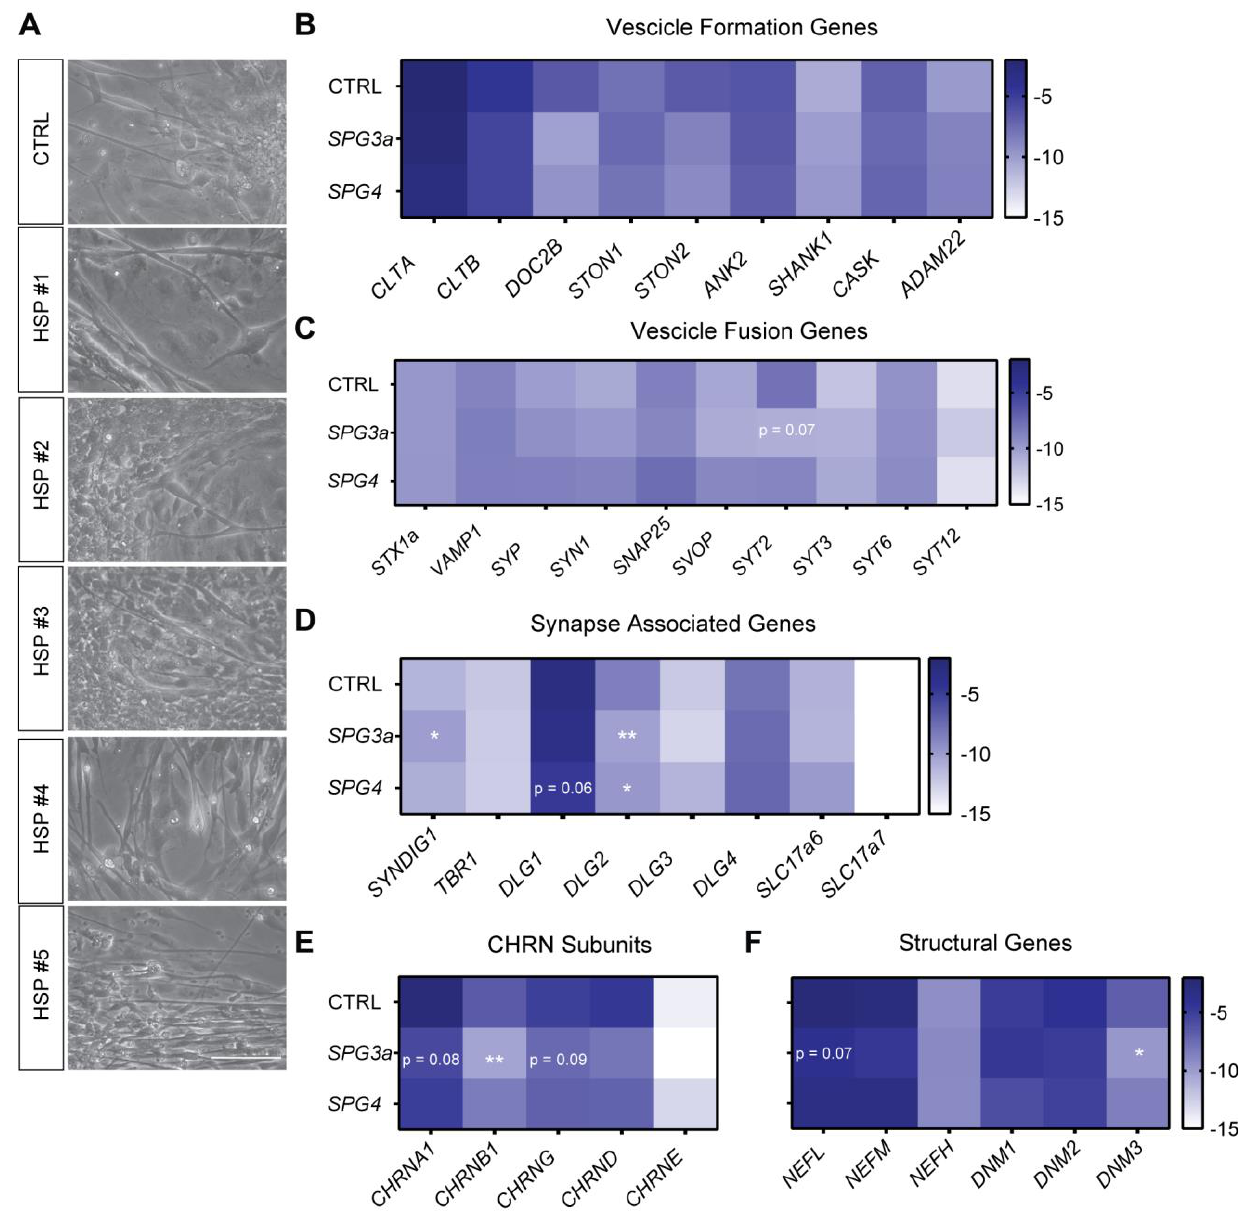
Figure 6. NMJ formation from CTRLs and HSP-patient derived myotubes and MNs. ( A ) Brightfield images of patient specific co-cultures with MNs and myotubes from CTRLs (three different hiPSC lines) and HSP-derived NMJs (#1, #2, #3 for SPG3a- and #4, #5 for SPG4 -mutated genotypes). Scale bars: 50 μm. Heat maps reporting genes regulating ( B ) vesicle formation ( CLTA , CLTB , DOC2B , STON1 , STON2 , ANK2 , SHANK1 , CASK and ADAM22 ), ( C ) vesicle fusion ( STX1a , VAMP1 , SYP , SYN1 , SNAP25 , SVOP , SYT2 , SYT3 , SYT6 and SYT12 ), ( D ) synaptogenesis ( SYNDIG1 , TBR1 , DLG1 , DLG2 , DLG3 , DLG4 , SLC17a6 and SLC17a7 ), ( E ) formation of the acetylcholine receptor ( CHRNA1 , CHRNB1 , CHRNG , CHRND and CHRNE ) and ( F ) the axonal structure ( NEFL , NEFM , NEFH , DNM1 , DNM2 and DNM3 ). Each data point was represented as ∆Ct, normalized for the housekeeping genes ( GAPDH and RPL13a ). Data were representative of three SPG3a - and two SPG4 -mutated HSP patients with each data point showing two experiments, and values were expressed as heat map. Data were analyzed by one-way ANOVA followed by a Dunnett post hoc test. Significance of the differences for SPG -mutated lines vs. CTRLs: * p < 0.05; ** p < 0.01. For p < 0.1, the actual value was reported. See also Figures S3 and S4 and Videos